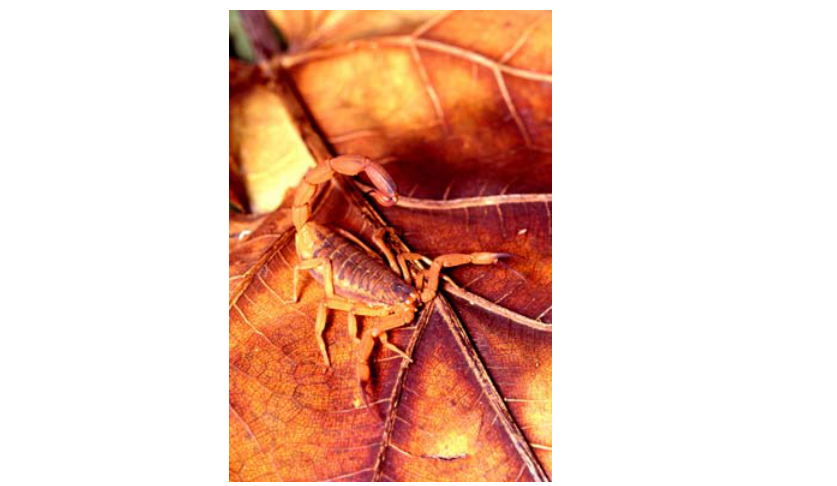
Figure 17. Female of Tityus serrulatus in the wild.